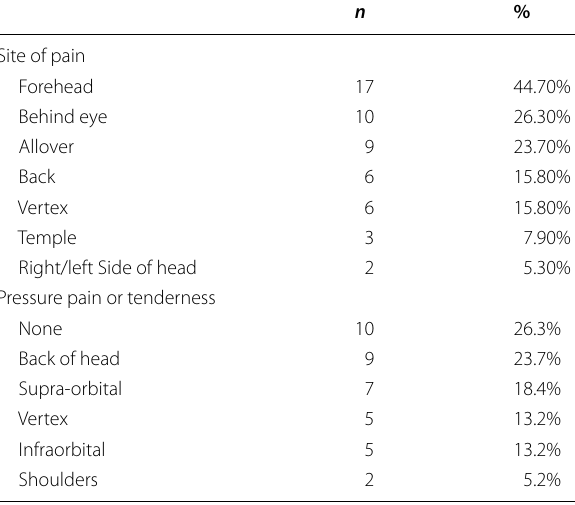
Table 4 Pain and trigger sites among